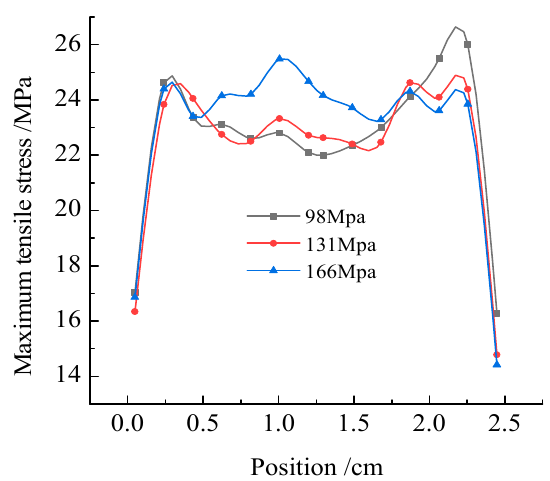
Figure 15. Variation of stress at the top of self-compacting concrete layer under different moduli of elasticity polymer lifting.